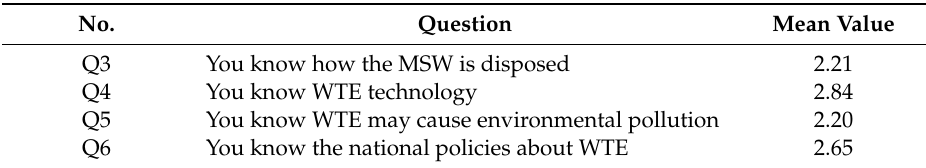
Table 4. The mean value of PAW towards